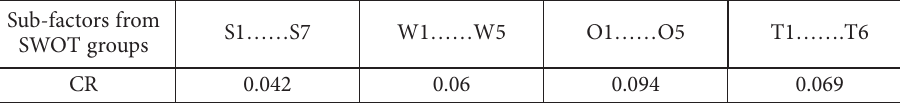
Table 7. Consistency ratio for sub-factors in SWOT groups Sub-factors from SWOT groups